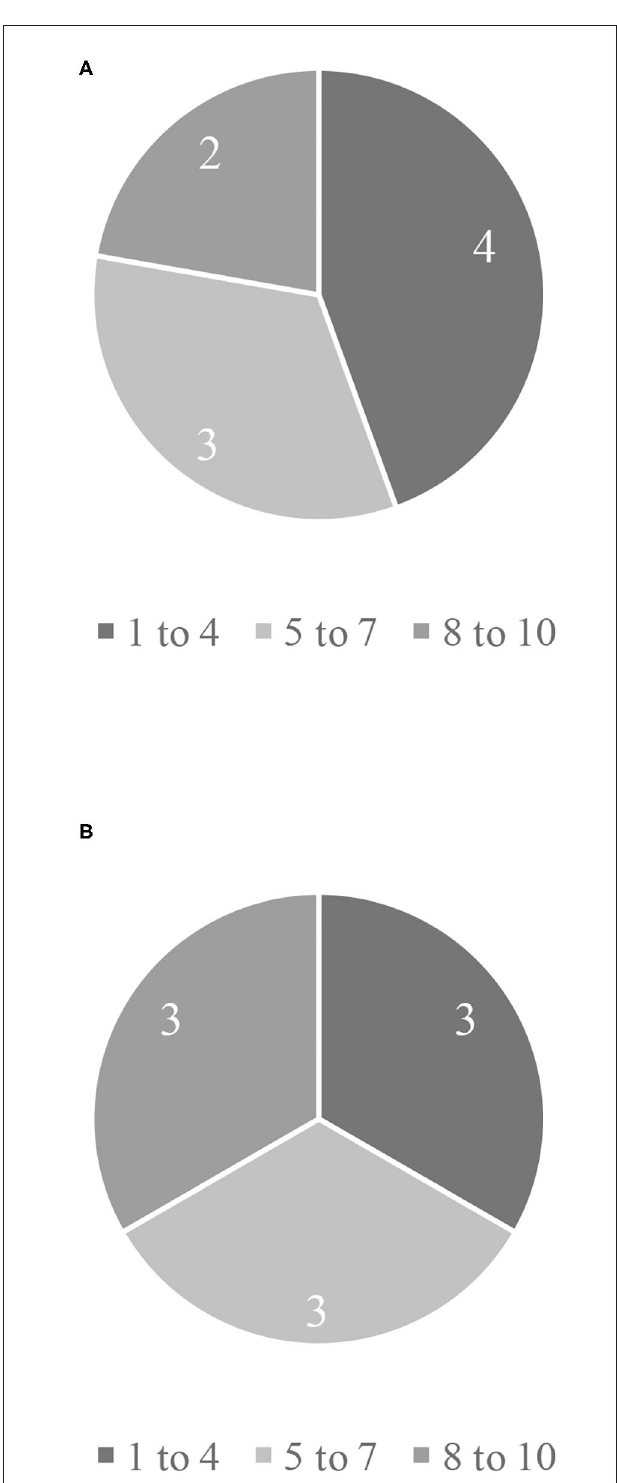
FIGURE 3 | Number of schemes in three score categories (1–4, 5–7, and 8–10, where 10 is the maximum score) illustrating how interested they were in joining the alliance if it were based on either model: (A) Option A: single set of higher welfare standards or (B) Option B: tiers of welfare